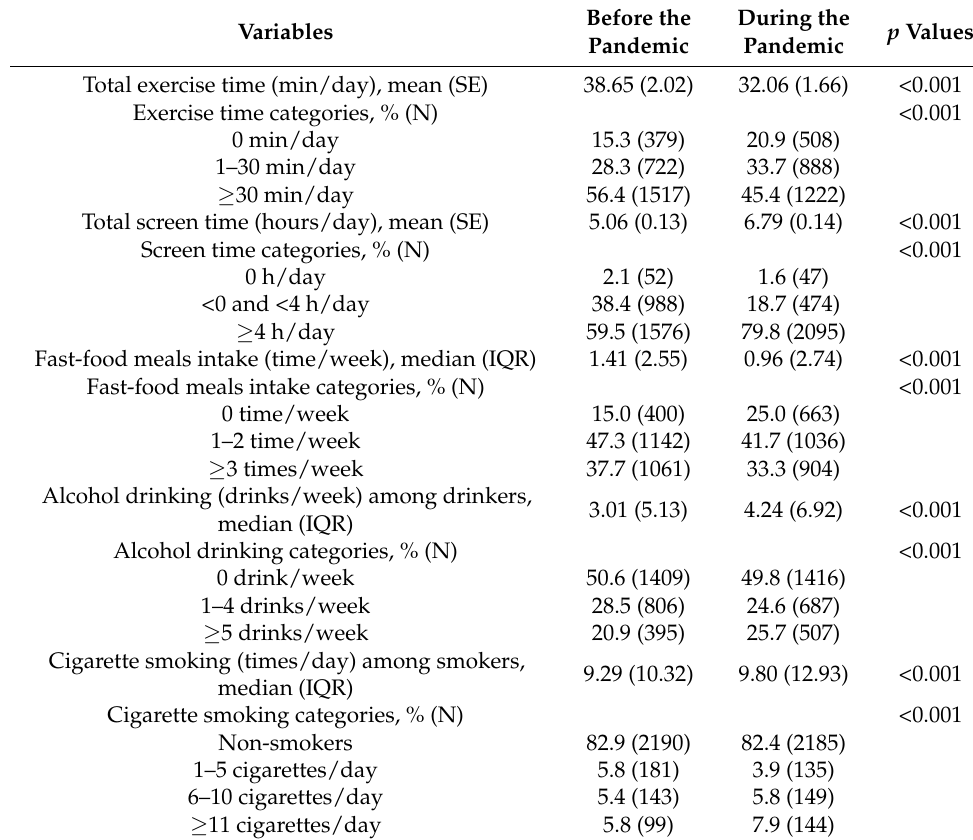
Table 2. Changes of lifestyle behaviors between before and during the COVID-19 pandemic.